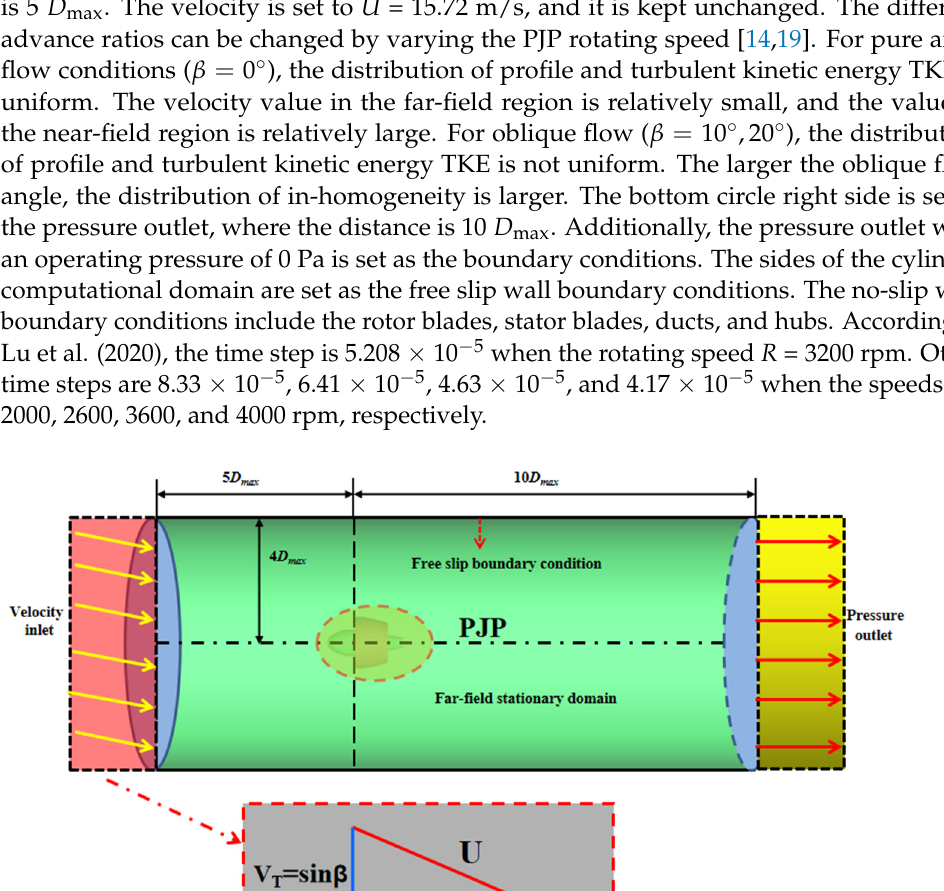
Figure 3. The difference of two boundary conditions.